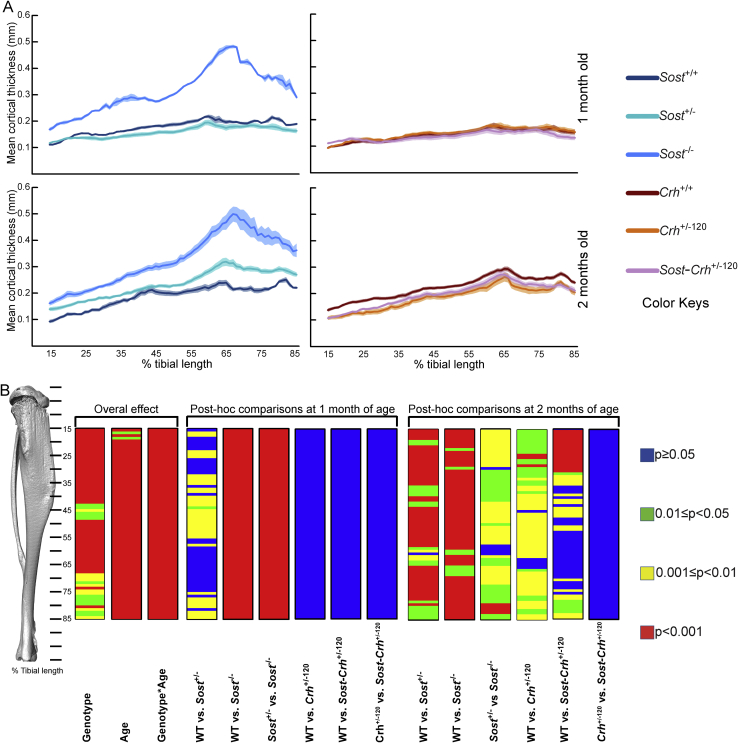
Sost haploinsufficiency does not rescue reduced mean cortical thickness (Cs.Th) induced by excessive glucocorticoids (GCs). A: Torsion (J) in Sost wild-type (WT) (dark blue; Sost+/+ WT), Sost heterozygous knockout (KO) (light blue; Sost+/−), Sost homozygous KO (turquoise; Sost−/−), Crh WT (dark red; Crh+/+), Crh heterozygous (orange; Crh+/−120), and double Sost-Crh heterozygous (plum; Sost-Crh+/−120) mice at 1 and 2 months of age. Lines represent the means; shading, the SEM. B: Graphic heatmap representation of statistical significance of the effect of genotype, age, their interactions as well as post hoc analysis along a 15% to 85% portion of the whole tibia length, excluding proximal and distal metaphyseal bone. n = 8 mice per group.